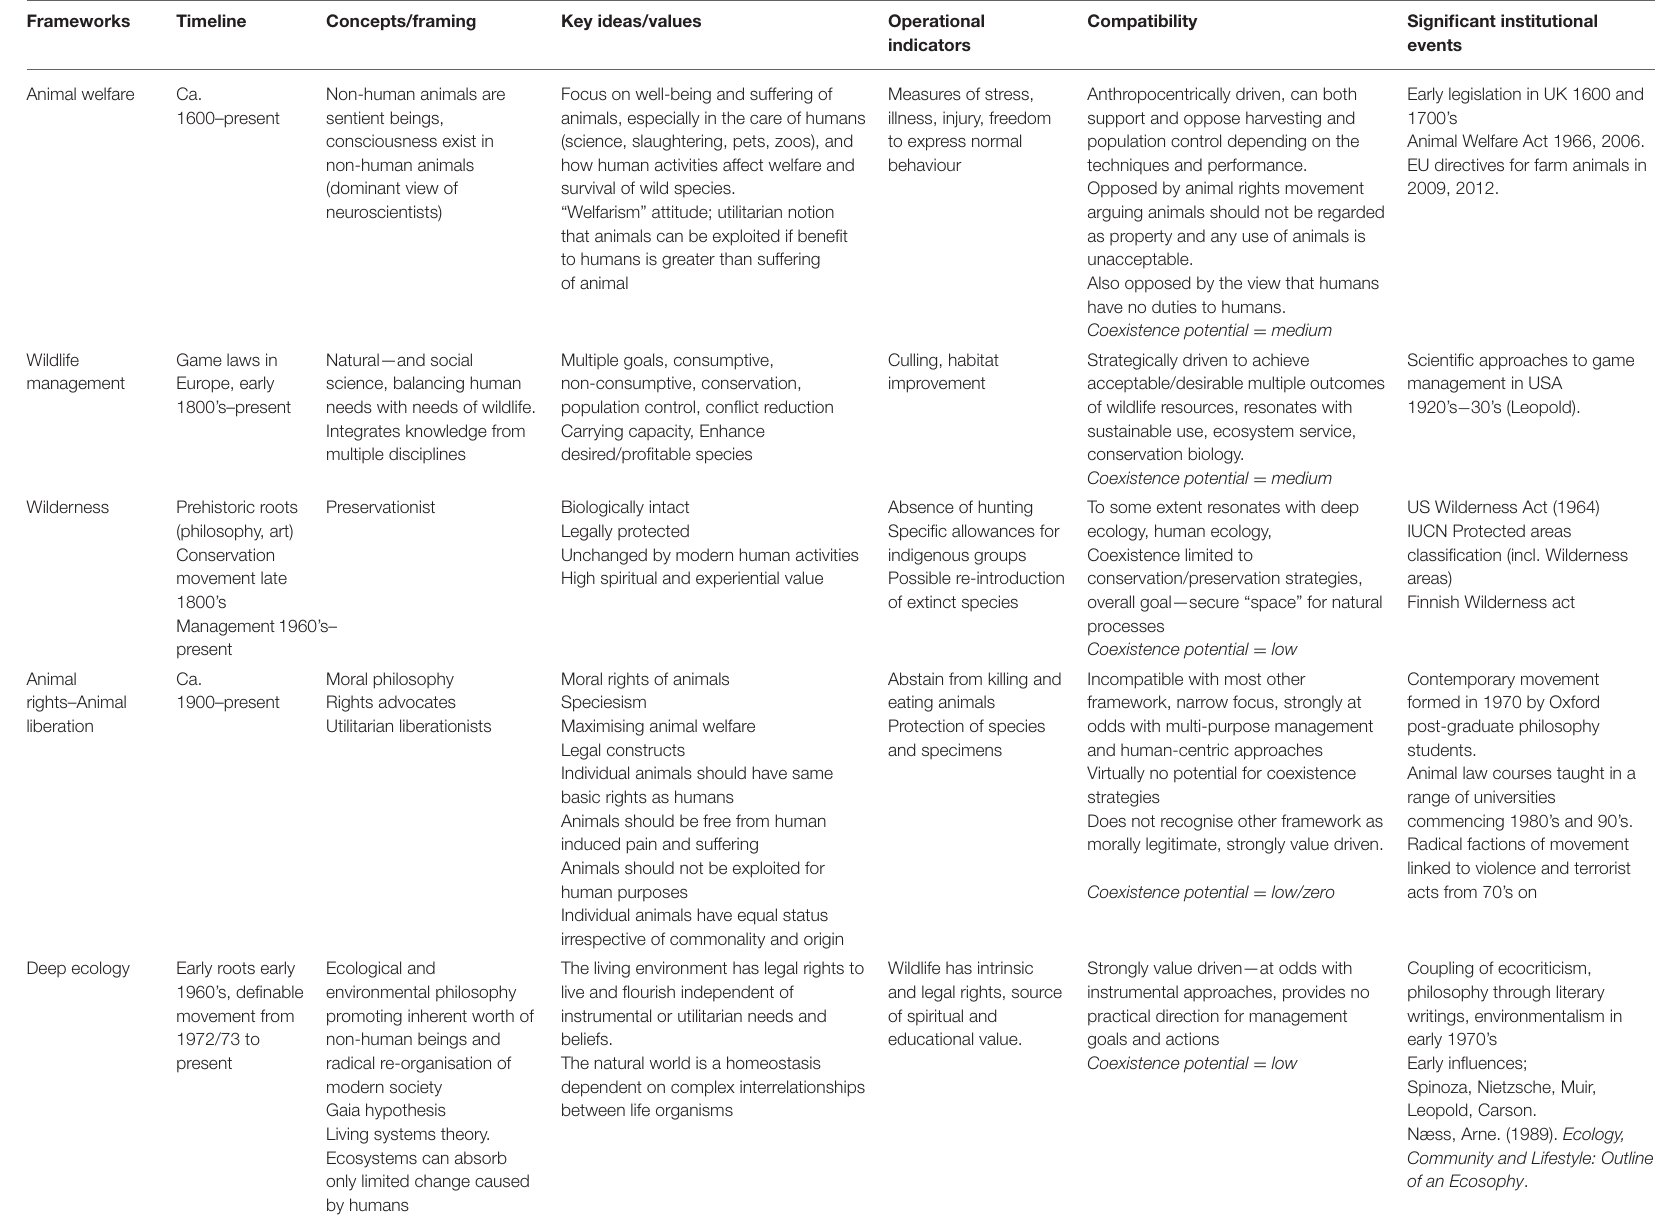
TABLE 2 | Main traits of frameworks and assessment of coexistence